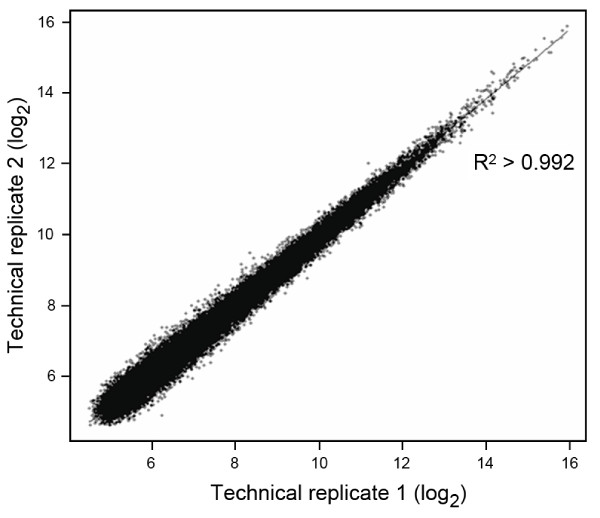
Microarray reproducibility. Scatter plot showing correlation between 2 microarray technical replicates (example shown on flax leaf sample, L). High correlations were found between all technical replicates (r = 0.98 or higher, p-value < 2.2e-16).